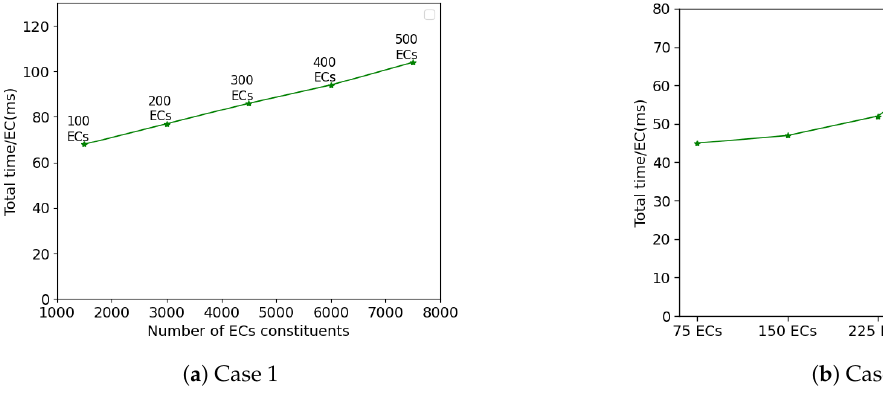
Figure 8. The results of the smart city experiments. Table 4. The results of case 2